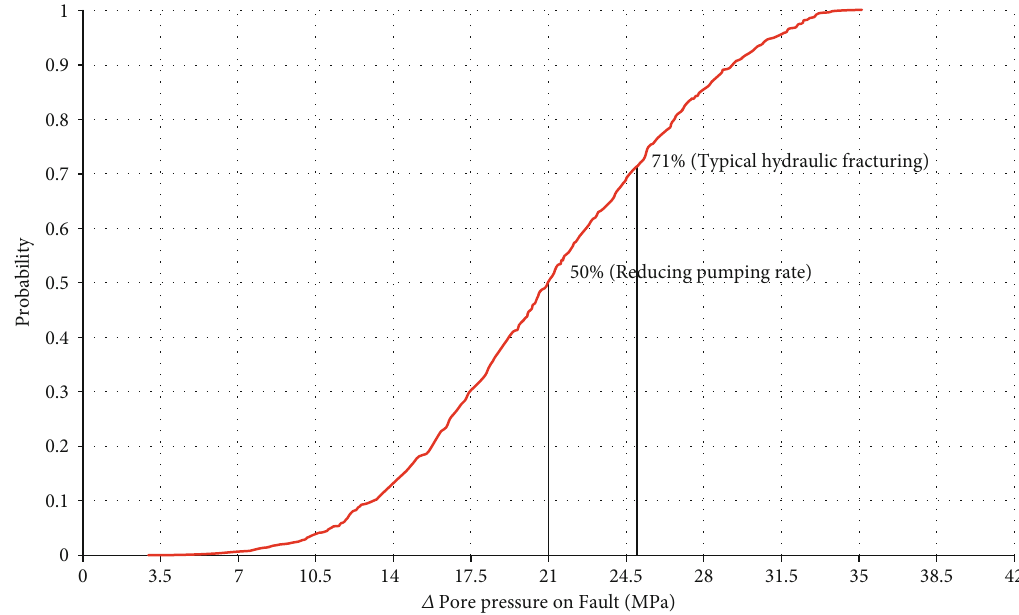
Figure 13: The slip probability curve of fault